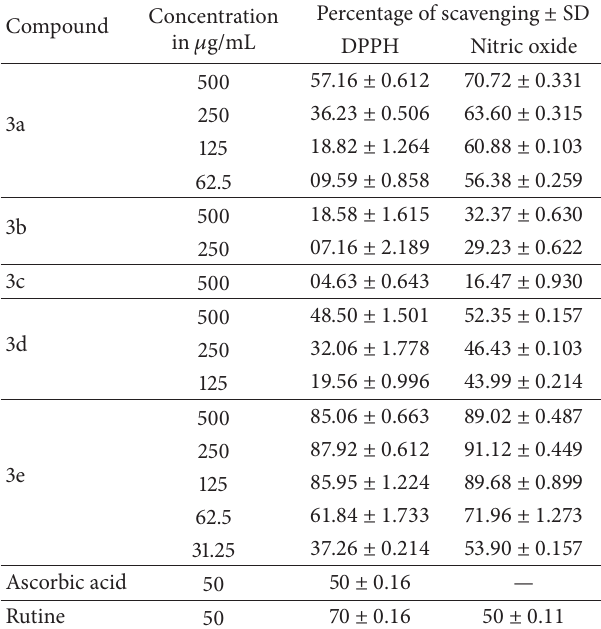
Table 4: Free radical scavenging activity of